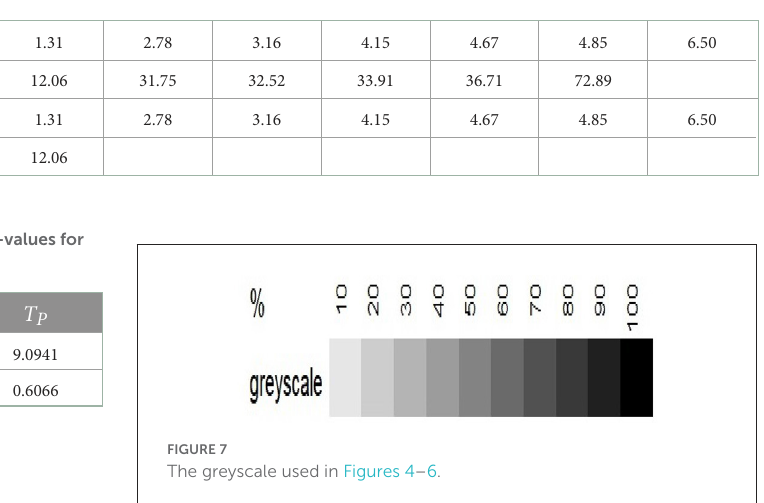
TABLE 6 Insulating fluid tested at 34 kilovolts data.